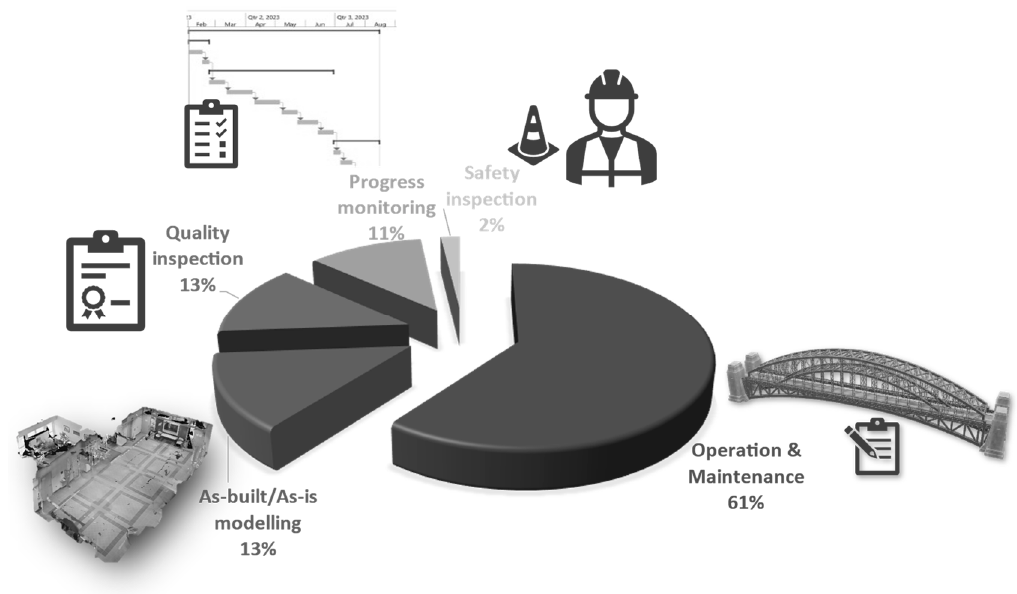
Figure 4. Application domains of using robots for inspection and monitoring.